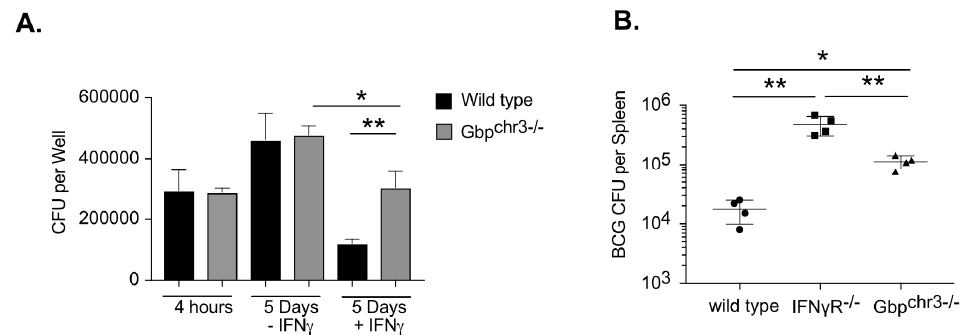
Figure 1. Guanylate binding proteins contribute to control of Mycobacterium Bovis BCG infection. ( A ) BMDMs from wild type or Gbp chr3 − / − mice were infected with M. Bovis BCG for 4 h then washed with fresh media in the presence or absence of IFN γ . Five days later the macrophages were lysed and serial dilutions were plated to quantify colony forming units (CFU) of viable BCG. Shown is the mean CFU from four biological replicates ± SD * p < 0.05 ** p < 0.01. Data are representative of four independent experiments. ( B ) Following IV infection with BCG (1 × 10 6 bacteria) the total bacterial burden (expressed in CFU, mean ± SD) was determined in the spleen of wild type of Gbp chr3 − / − mice 50 days following infection. Representative of two independent experiments with 4–5 mice per group, * p < 0.05 ** p <